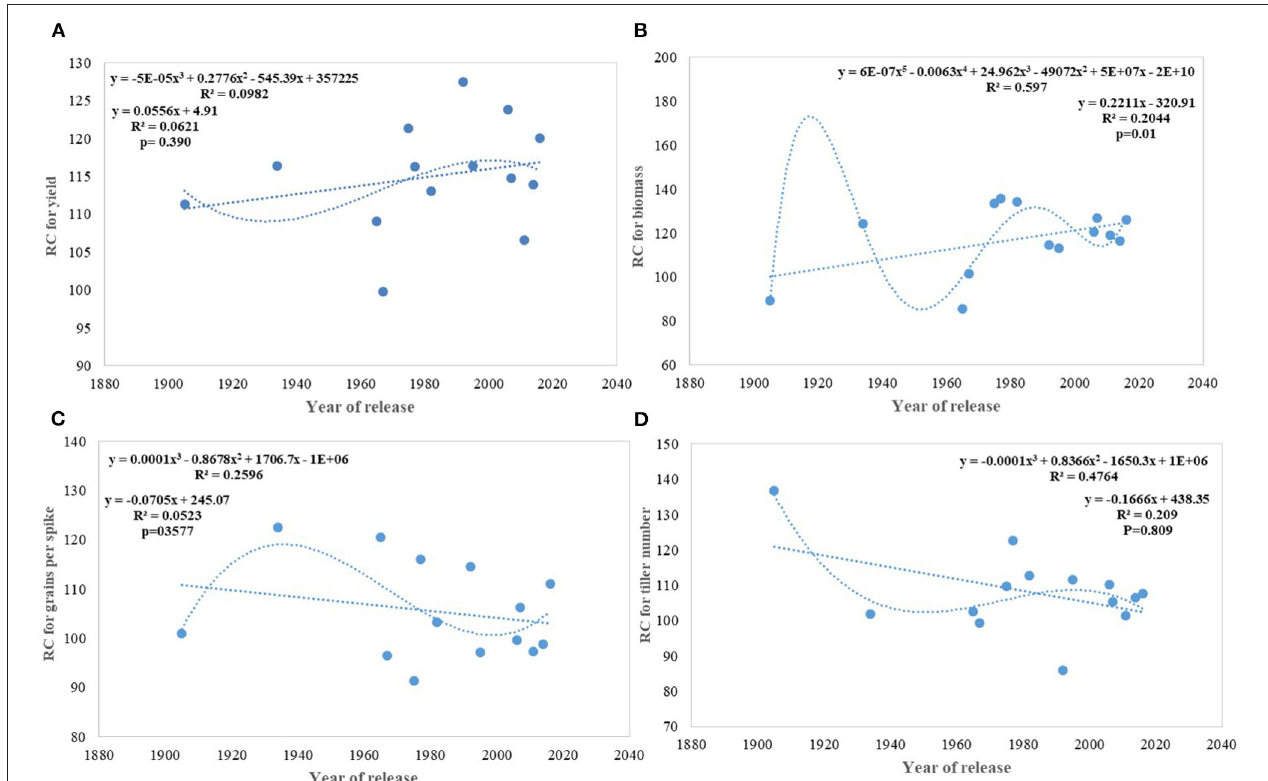
FIGURE 8 | Relative competitiveness for yield and component traits against the year of release. (A) yield, (B) biomass, (C) grains per spike, (D) tiller